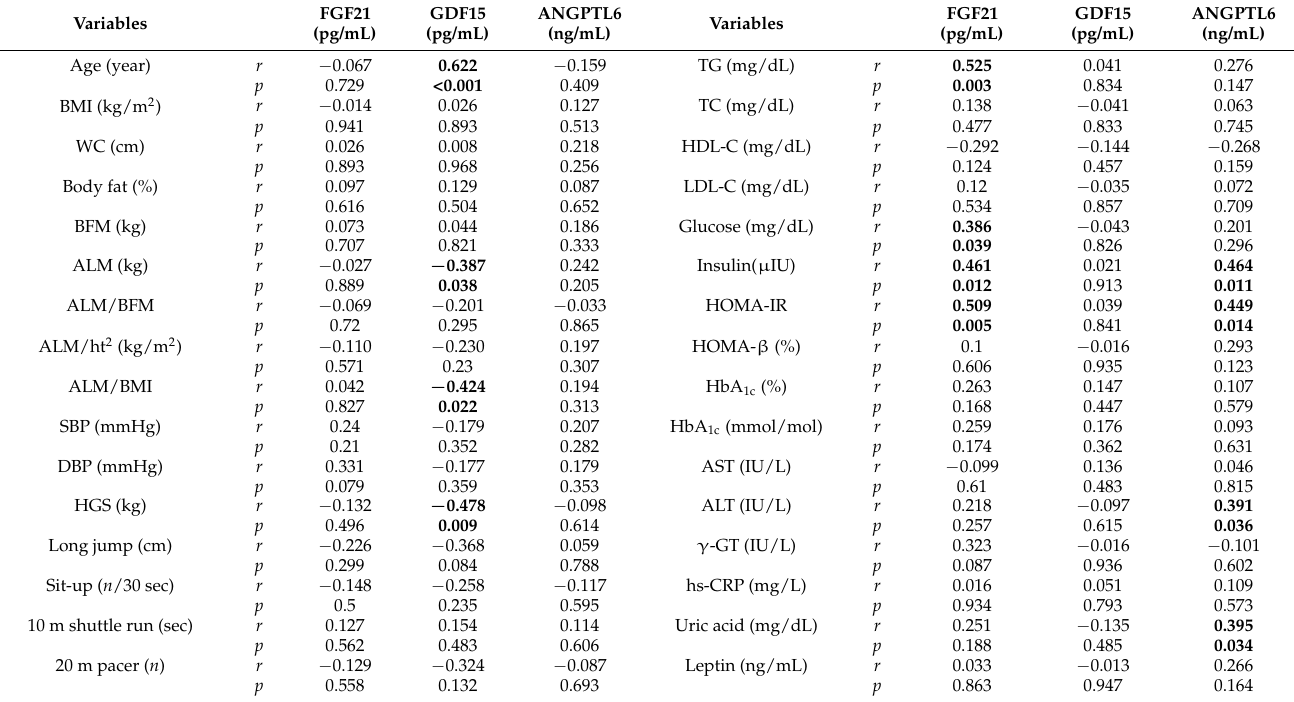
Table A2. Correlation matrix of baseline serum levels of FGF21, GDF15, and ANGPTL6 with parameters evaluated in the